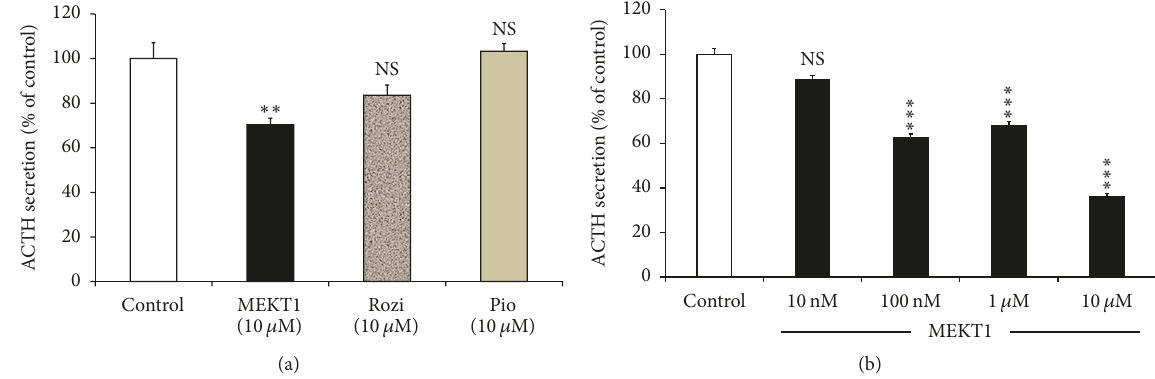
Figure 3: Effects of MEKT1, rosiglitazone, and pioglitazone on ACTH secretion from AtT20 cells. (a) Effects of MEKT1, rosiglitazone, and pioglitazone on ACTH secretion into the media from AtT20 cells. AtT20 cells were treated with MEKT1, rosiglitazone (Rosi),and pioglitazone (Pio) (10 𝜇 M) or DMSO (0.1%) as a control. After 24-hour incubation of the cells, the ACTH secreted to the media was determined by EIA. (b) Dose-dependent effects of MEKT1 on ACTH secretion into the media from AtT20 cells. AtT20 cells were treated with MEKT1 (10nM, 100nM, 1 𝜇 M, or 10 𝜇 M) or 0.1% DMSO (vehicle control) for 24 hours. After 24-hour incubation of the cells, the ACTH secreted to the media was determined by EIA. Data are expressed as percentages (100%) of control. Each point represents mean ± SEM ( 𝑛 = 4 ). NS means “not significant.” ∗∗∗ 𝑃 < 0.001 , ∗∗ 𝑃 < 0.01 versus